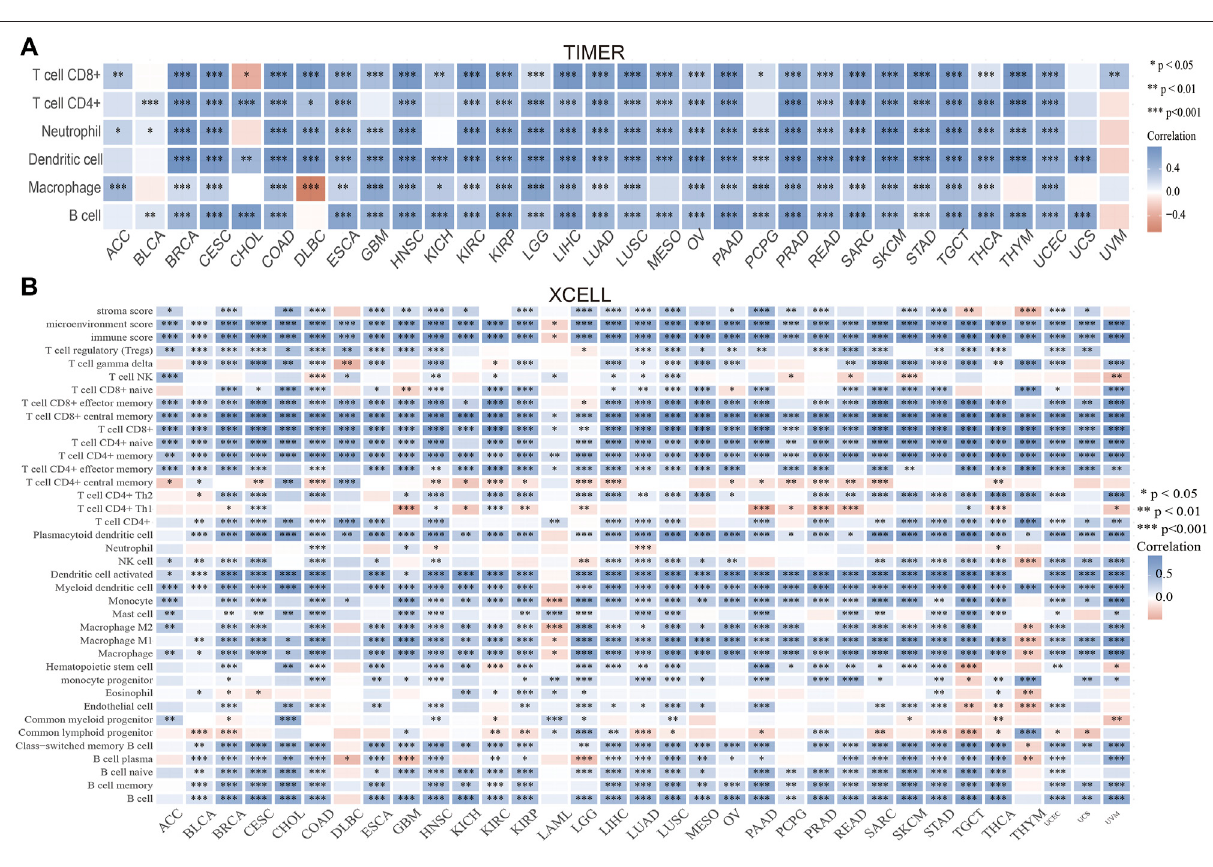
FIGURE 5 | Analysis of the correlation between the PAFAH1B3 expression and immune cells in fi ltration. (A) The correlation between PAFAH1B3 expression and immunecellsin fi ltration inpan-cancerwasexaminedbytheTIMERdatabase. (B) Thecorrelation betweenPAFAH1B3 expressionand diverseimmunecellsin fi ltration in pan-cancer examine by Xcell database. * p < 0.05, ** p < 0.01, *** p <